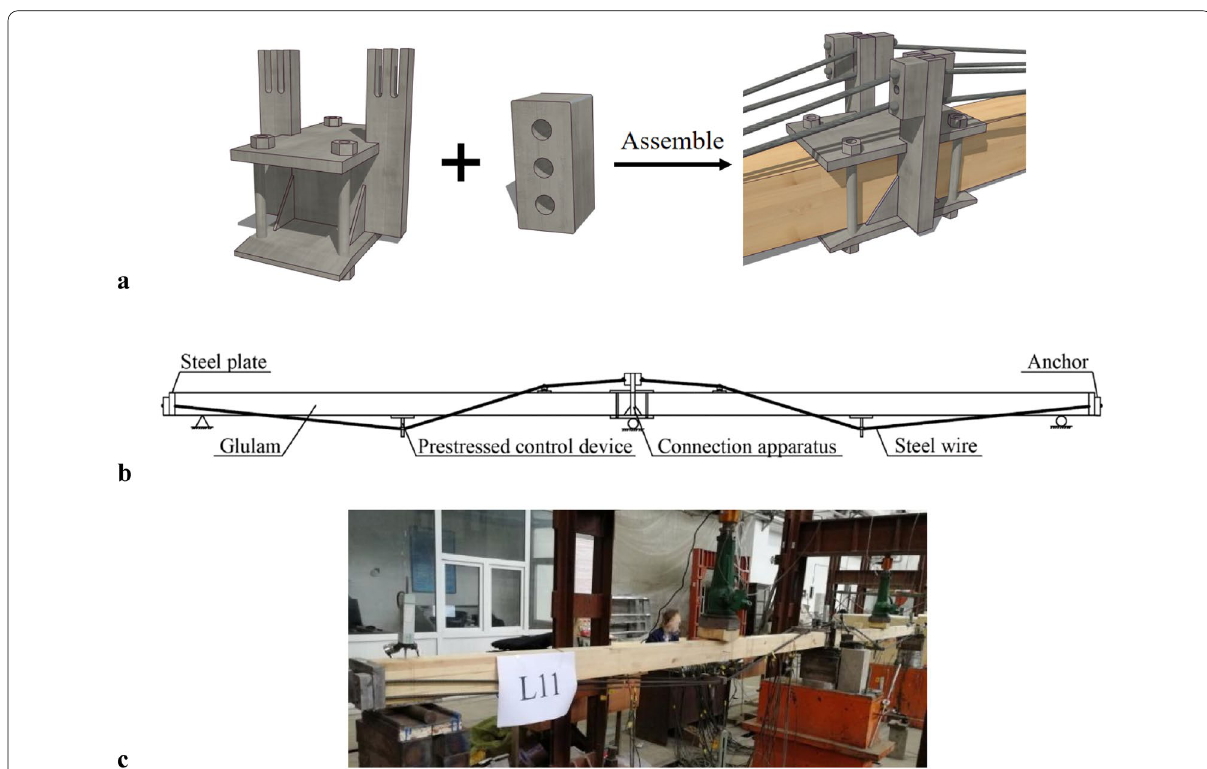
Fig. 1 Prestressed glulam continuous beam. a Details of connection apparatus; b details of the specimen; c photo of the